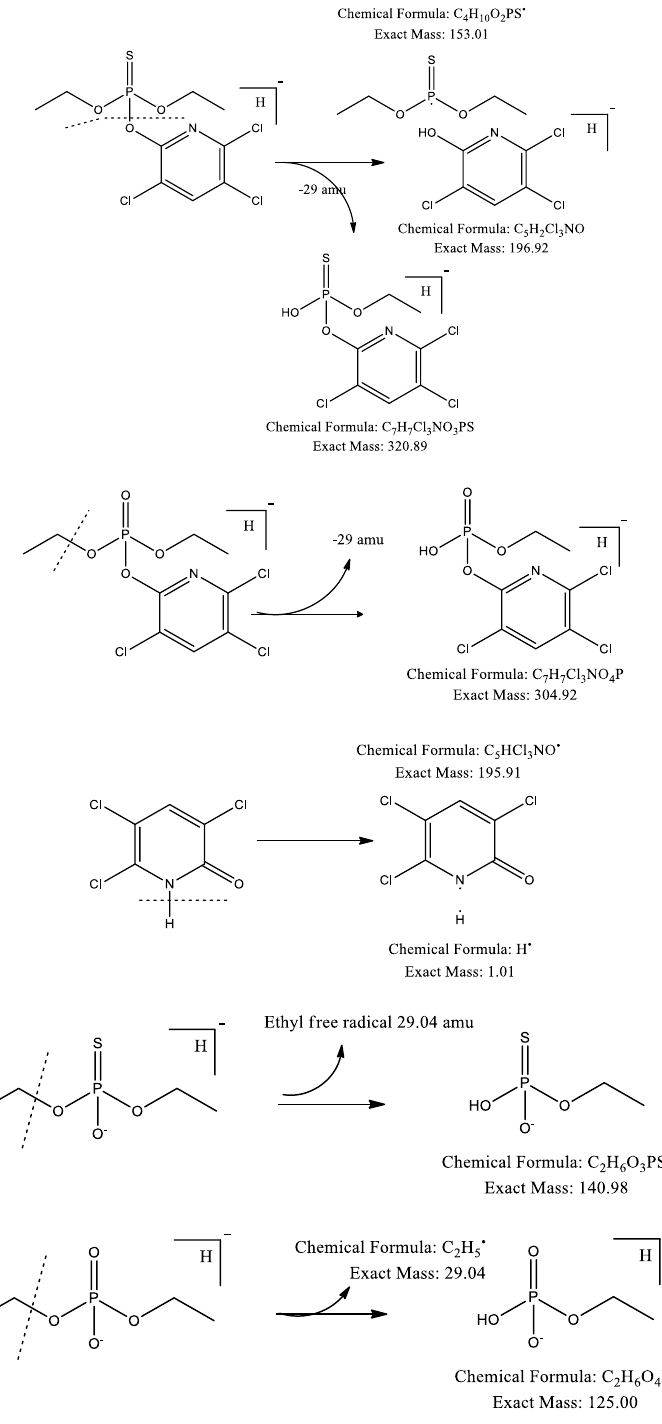
Figure 4. Purposed degradation pathway of